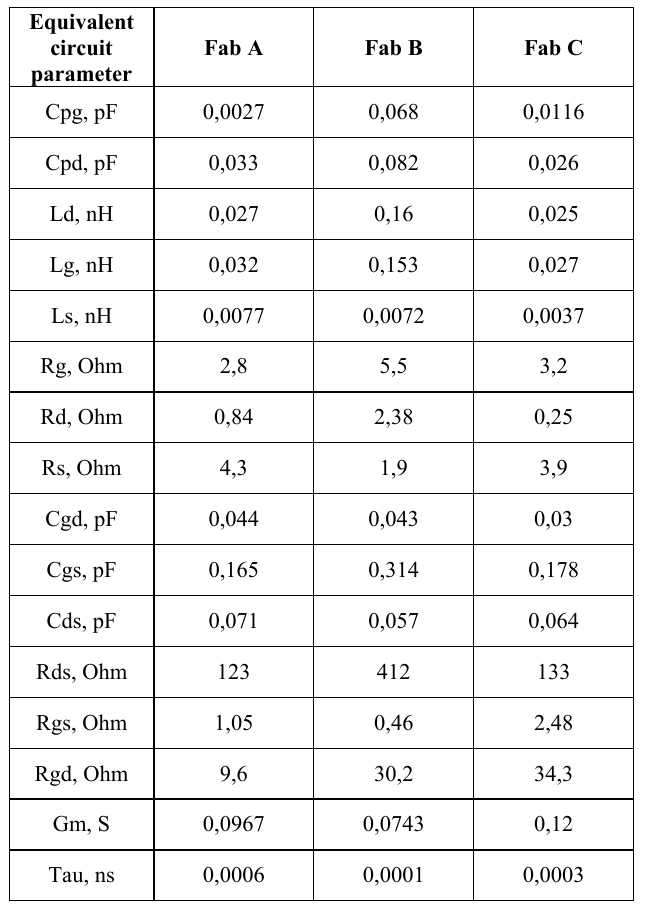
Table 1. Extracted parameters for pHEMTs manufactured at different